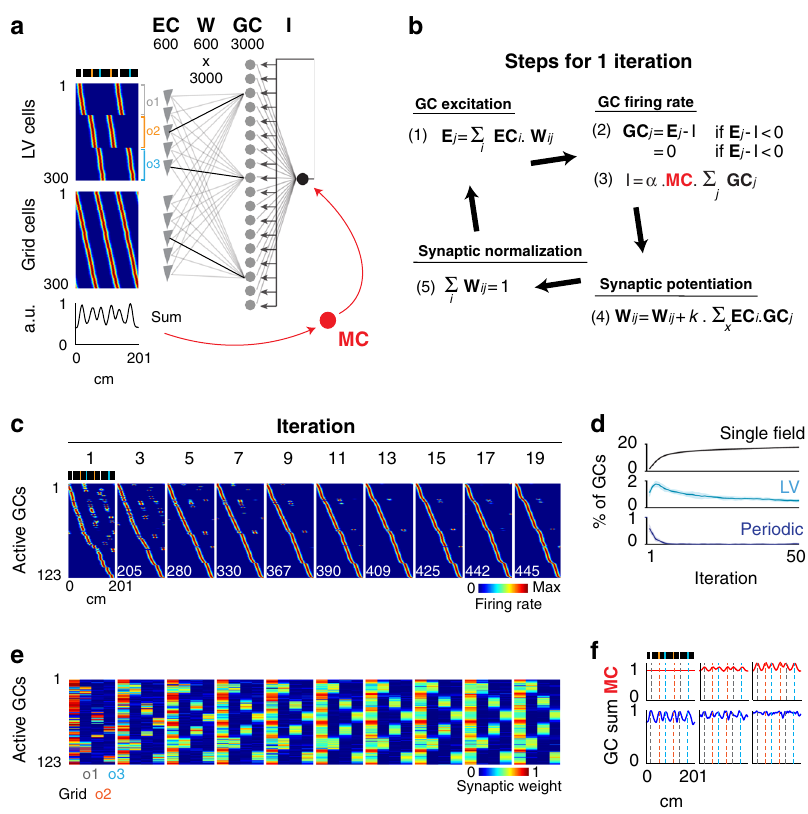
Fig. 7 Modeling of single- fi eld emergence via competitive learning. a Model architecture. A total of 3000 GCs receive excitatory inputs from 300 LV cells and 300 grid cells from the EC and are subjected to feedback inhibition. The EC-to-GC synaptic weight matrix is referred to as Wij. The threshold used as feedback inhibition is referred to as I. Color coded, rate maps of EC LV cells (upper) and grid cells (lower). The fi ring fi elds were generated with Gaussian functions. LV cells encode various distances to landmarks, while grid cells have various spatial phases and the same periodicity as periodic cells. In red, the effect of MC feedforward inhibition is added to the model. The spatial modulation of MC activity is assumed to be proportional to the dynamic range of EC average activity. The color scale is the same as that used in ( c ). b All operations executed during one model iteration. (1) The excitation Ej received by the GCj in a given position. (2) The fi ring rate of GCj and (3) the feedback inhibition I in that position. The value of I is estimated numerically by fi nding the value among a range of I values that best satis fi es relations (2) and (3). (4) The potentiation of synaptic weights, proportional to the level of cells ’ co- fi ring throughout the belt. (5) The normalization of synaptic weights. c Transformation of spatial representations across iterations. Color-coded representation of rate maps for active GCs, across iterations. Active cells have a mean activity >0 and are sorted according to fi ring fi eld positions. Note the increase in the number of active GCs (lower left numbers) and the transformation of representations from multiple to single place fi elds. d Evolution of the fraction of single, LV and periodic fi elds across iterations. e For each active GC, the color-coded representation of the total synaptic weight contributed by grid cells and by each population of LV cells (encoding a speci fi c landmark) is shown across iterations using the same GC ordering as in ( c ). Note that synaptic inputs initially originate from one source and are progressively redistributed equally among grid cells and LV cells. f Effect of the distinct magnitude of MC modulation on the GC mean